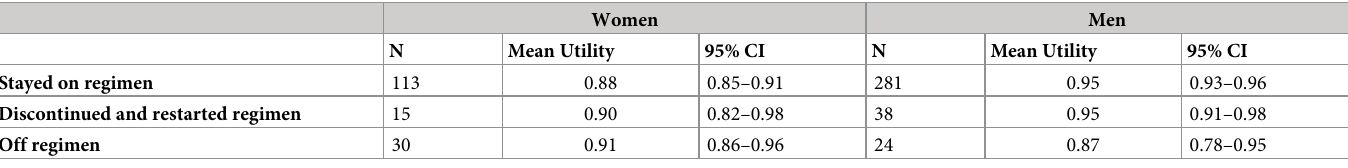
Table 3. Mean EQ-5D utility (Quality of life) score at week 48 by continuation of study